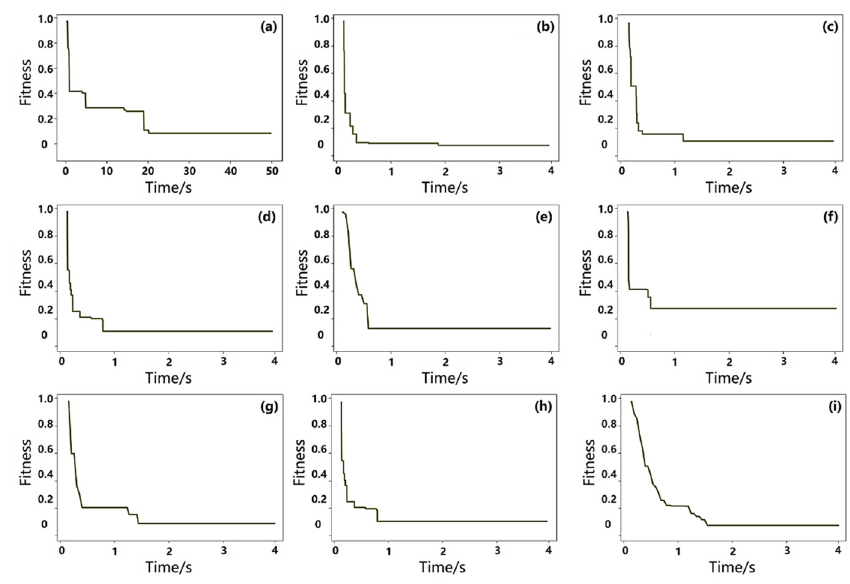
Figure 9. The best fitness convergence curves of the two methods in 10 tests. ( a ) is the fitness con-